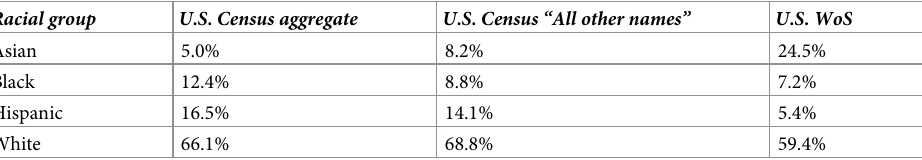
Table 3. Racial distribution in U.S. Census and WoS U.S. Authors with known family names.